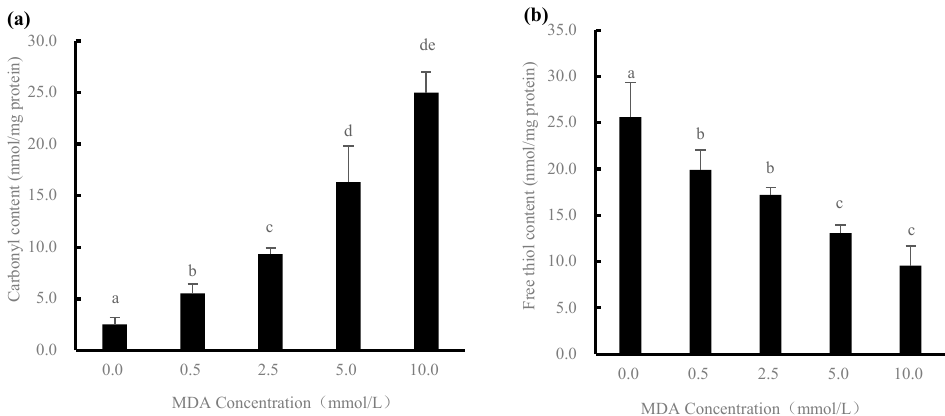
Figure 2. Changes in carbonyl content ( a ) and free thiol content ( b ) of duck myofibrillar proteins treated with different malondialdehyde (MDA) concentrations (0, 0.5, 2.5, 5.0, and 10.0 mmol/L). Different letters (a–e) indicate significant difference ( p < 0.05).